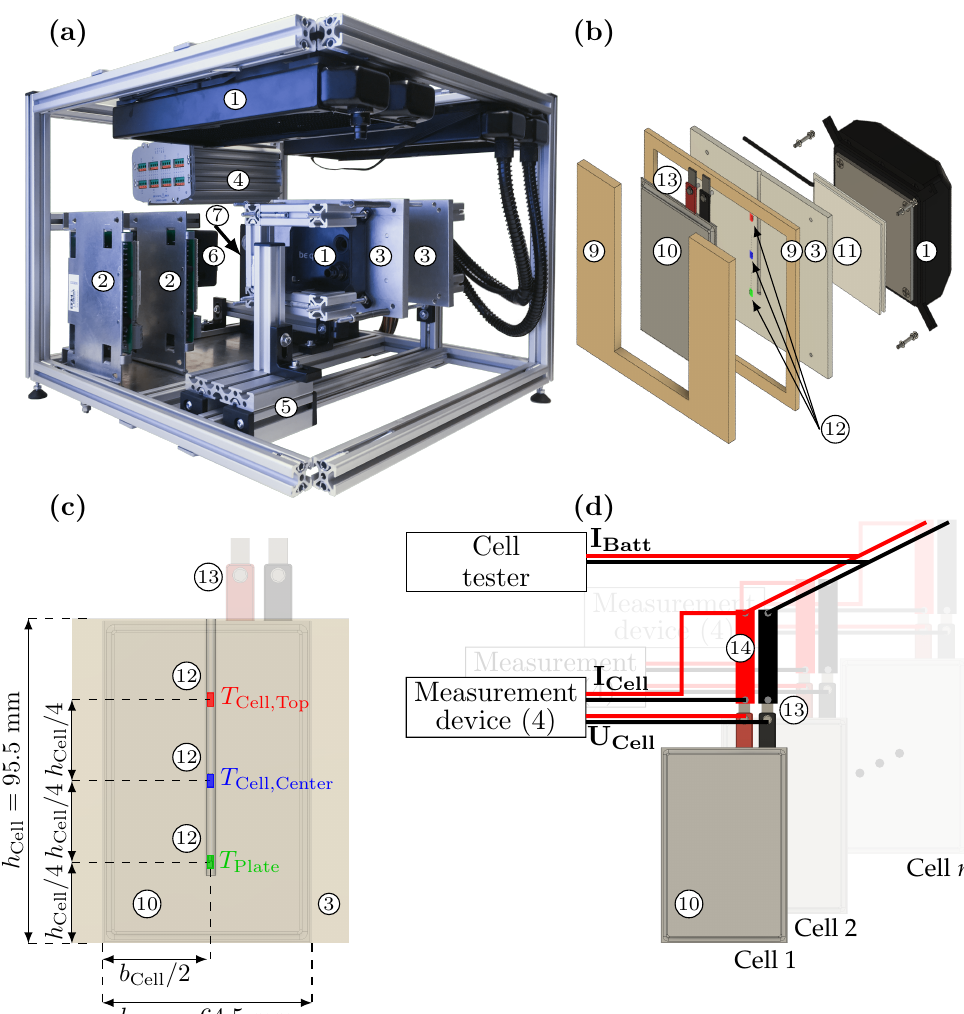
Figure 1. Setup of the test bench. View-optimized modifications of the test bench with removed cooling tubes, cables and one aluminum profile ( a ). Schematic view of the temperature control system including the positions of the Pt100 sensors (12) ( b ). Detailed view of the position and orientation of the temperature sensors ( c ) and a detailed view of the electrical connection of the cells to the cell tester ( d ). Measurement data, including six Pt100 temperature sensors (12), three for each cell side, as well as two voltage signals, are recorded with a frequency of f = 100 Hz. The signals are transferred